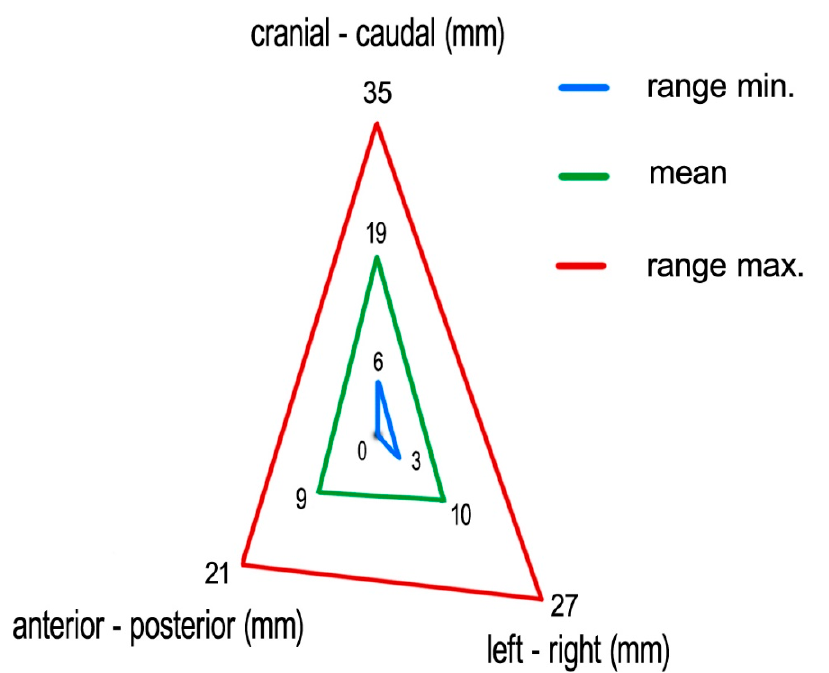
Figure 6. Mean tumor excursions (with range max/min) as recorded with 4D-CT.